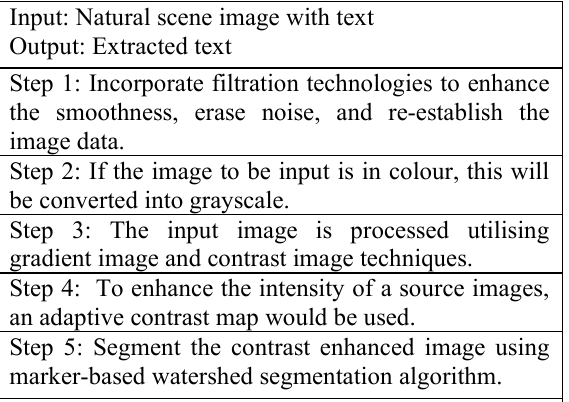
Figure 1. Work flow of suggested methodology for text extraction Table 1. Algorithm of proposed methodology for entire text extraction process